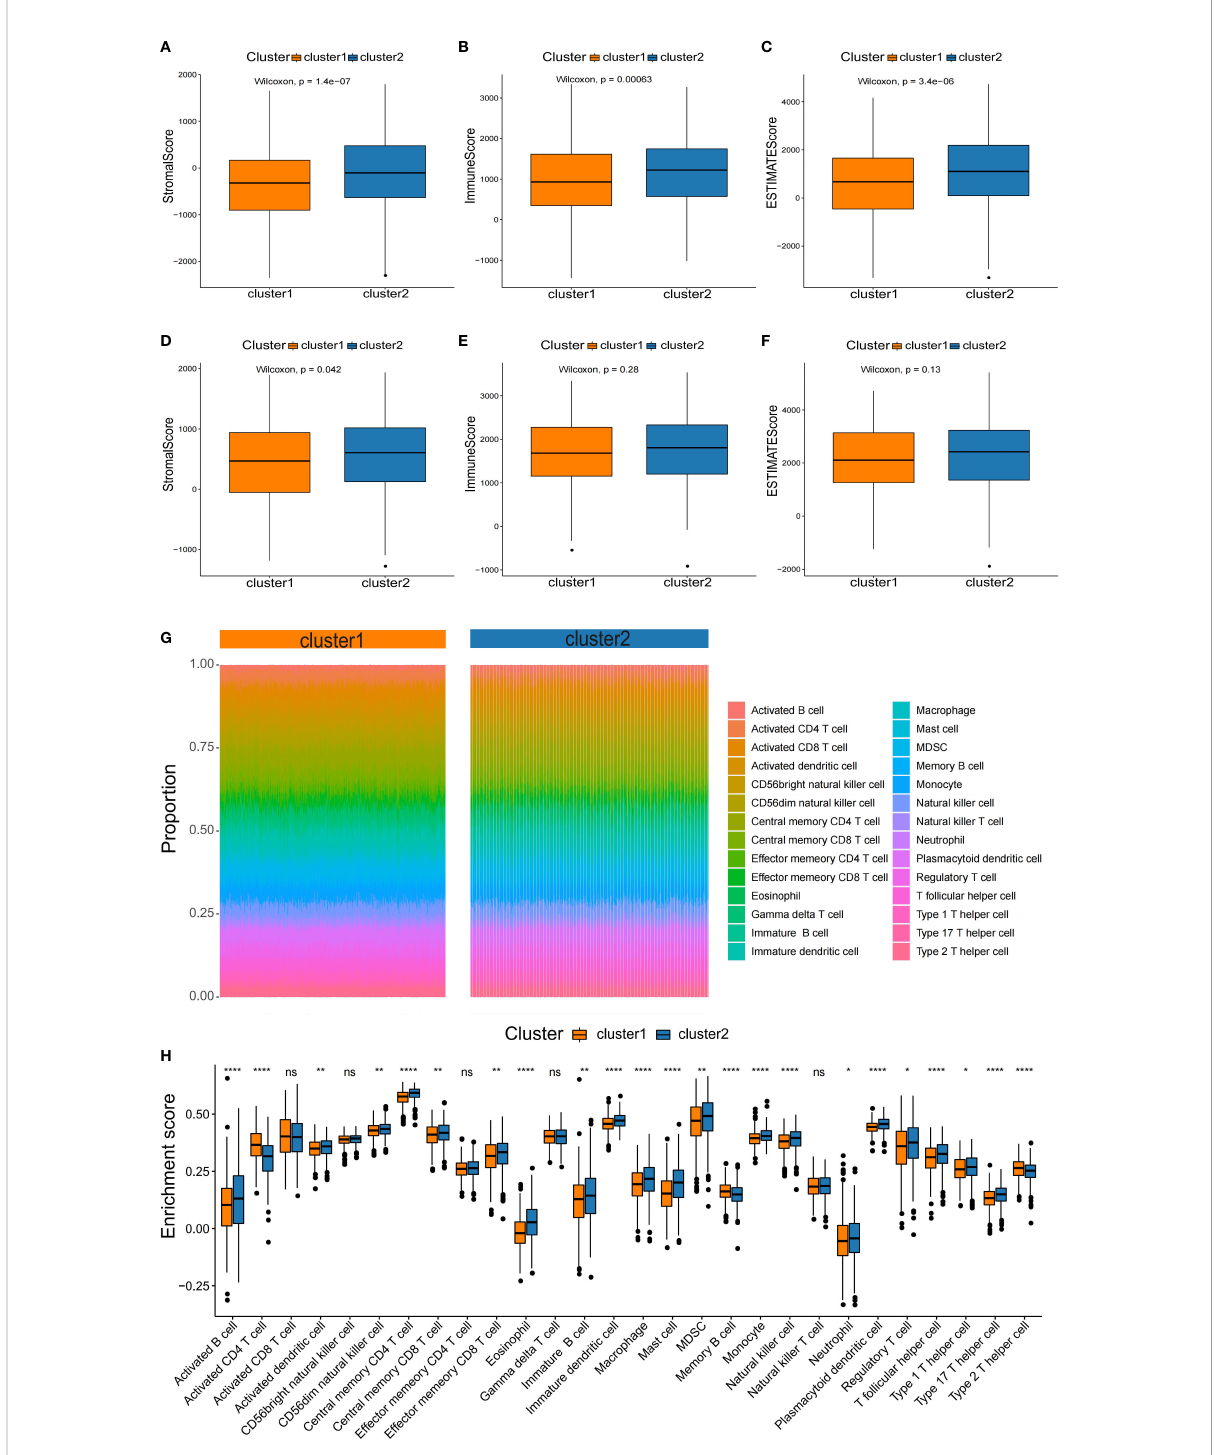
FIGURE 5 Characterization of the immune in fi ltration landscape of the two NSCLC subtypes. (A – F) Box plots of immune score, stromal score, and total score for NSCLC subclasses derived from ESTIMATE. The lines within boxes on box plots represent median values. The bottom and top lines represent the minimum and maximum values, respectively. (G) Heatmap showing the proportion of 28 types of in fi ltrating immune cells in C1 and C2 by ssGSEA algorithms. (H) Comparison of the proportion of 28 types of in fi ltrating immune cells between the subtypes by the rank sum test. NS denotes P>0.05, * indicates P ≤ 0.05, ** represents P ≤ 0.01, *** indicates P ≤ 0.001, and **** indicates P ≤